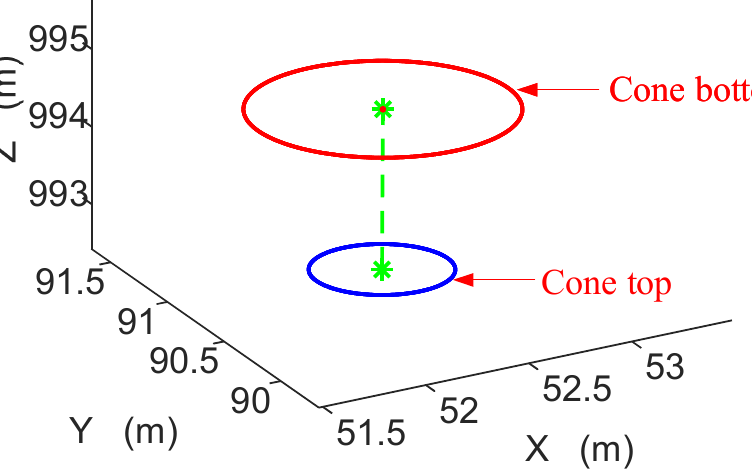
Figure 5. The trajectories of the scatterer points at the cone top and bottom. First, the high-resolution 1D range sequences of two scatterers are obtained by the wideband radar. Because the micro-motion component is perpendicular to the radar LOS, the 1D range sequences of the target are two straight lines on the slow-time-range plane. The imaging results are shown in Figure 6. The normalized amplitude reaches the peak when the ranges are 998.5 m and 1000.35 m. Therefore, the estimated ranges of the two scatterers at cone top and bottom are 998.5 m and 1000.35 m